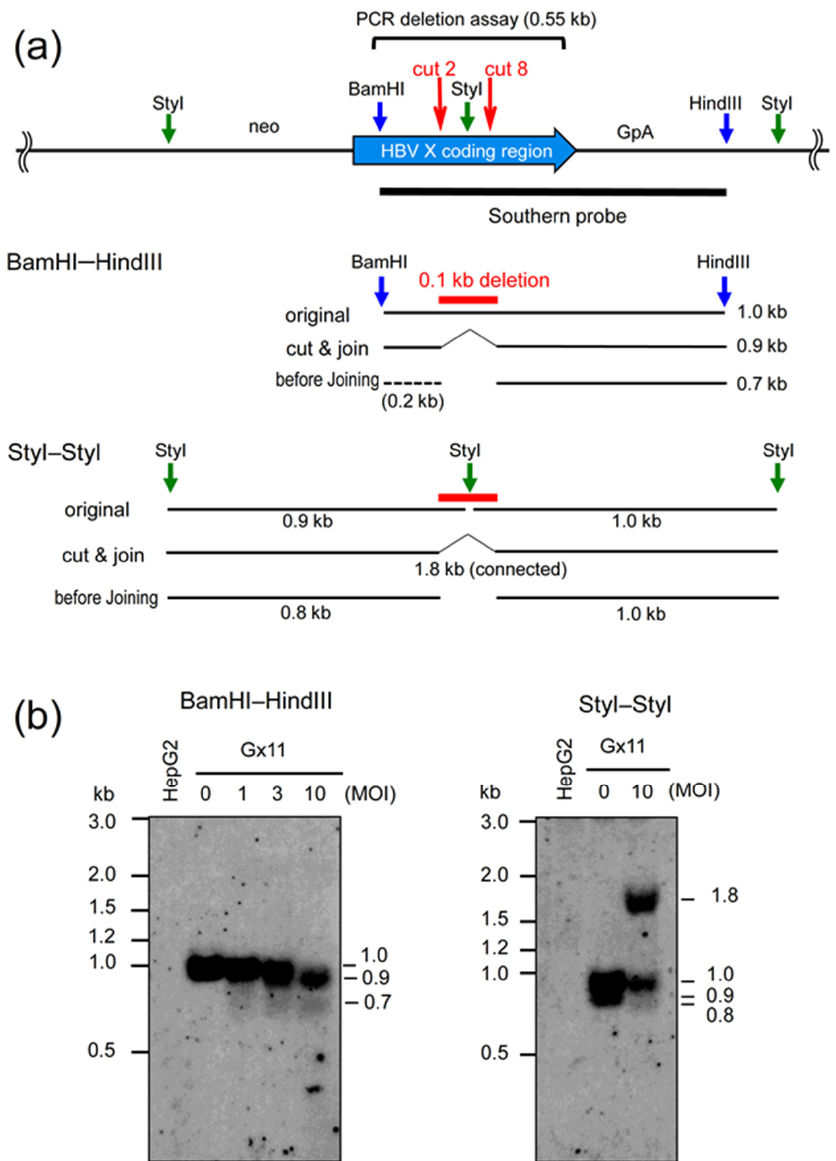
Figure 3. Southern analyses of HBV X gene integrated in Gx11 cell chromosome disrupted by the AdV expressing eight gRNA units. ( a ) The deleted region of the HBV X gene. All cleaved positions and the ends of the produced fragments are common among the upper, middle, and lower parts. (Upper) Cleavage sites of Cas9 and restriction enzymes used for Southern experiments at the HBV X coding region. The cleavage sites of cut 2 and cut 8 are shown as red vertical arrows on the HBV X coding region of the bold horizontal arrow. The 0.55 kb fragment amplified in the PCR deletion assay is shown above the arrow of the HBV X coding region; the range of the Southern probe (BamHI–HindIII fragment) is also shown below the HBV X arrow. neo, neo gene used for the selection of Gx11 cells; GpA, poly(A) sequences of the rabbit β -globin gene. These sequences are present because the integrated DNA fragments are derived from the pCAGGS plasmid. (Middle) The positions of the BamHI–HindIII fragment containing the deletion between cut 2 and cut 8. Because the same enzymes BamHI and HindIII are used for preparation of the Southern probe and for cleavages of total cell DNA, their terminal positions are the same. Expected sizes of the fragments in Southern analysis are shown on the right in kb. (Lower) The positions of the StyI–StyI fragment containing the deletion between cut 2 and cut 8. ( b ) The results of Southern analyses. Gx11 cells were infected with Axg8HBV-X at the indicated MOIs together with AxCas9 at the same MOI. The original 1.0 kb band shifted to 0.9 kb at MOI 10, which is 0.1 kb shorter. This indicated that the original BamHI–HindIII of 1.0 kb DNA was cleaved at cut 2 and cut 8 and the termini were end-joined, producing 0.9 kb DNA (Figure 3b, left panel, lane 10; explanations are shown in Figure 3a, middle panel, BamHI–HindIII, “original” and “cut & join”). This result also corresponded well with that obtained in the PCR deletion assay,